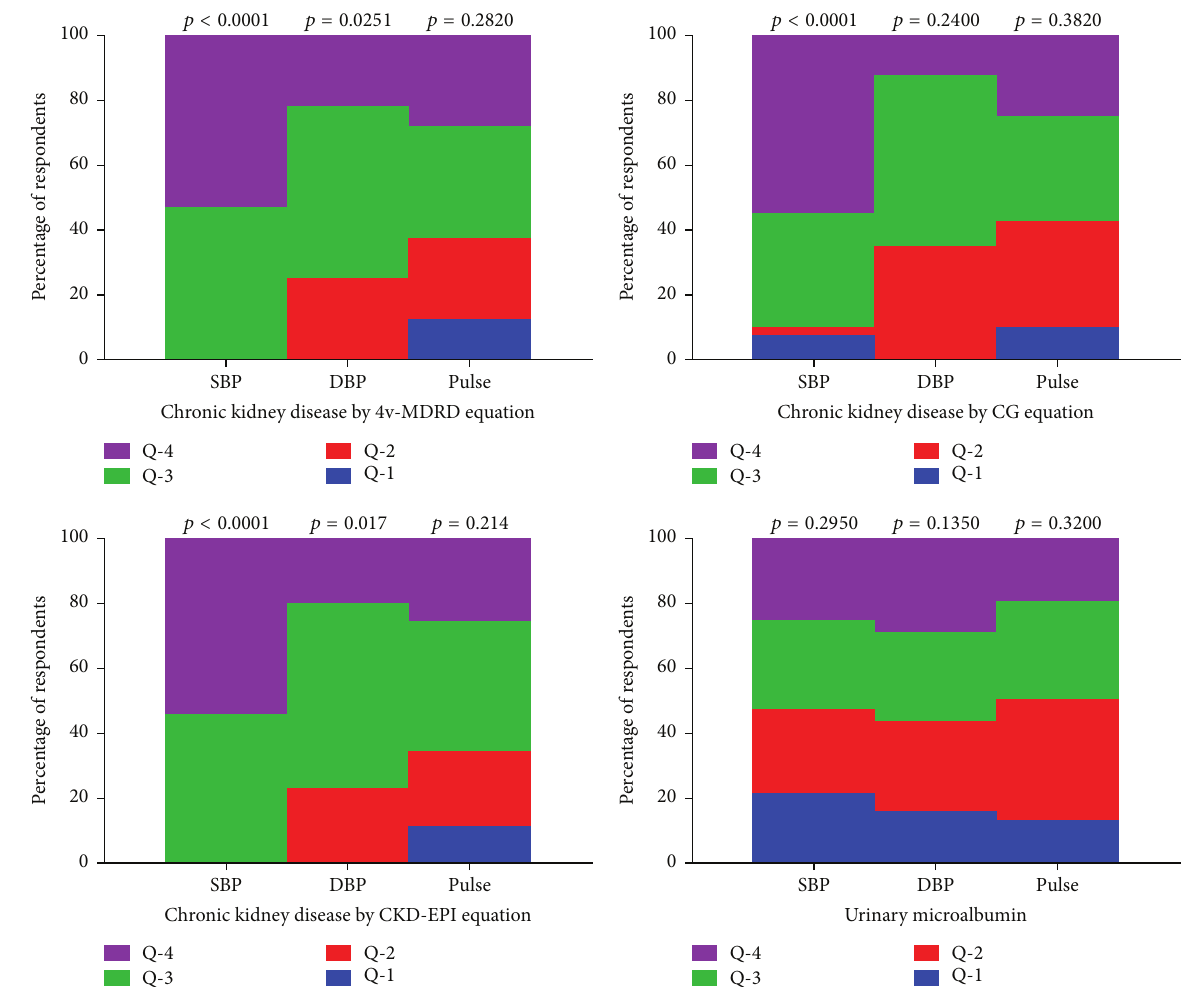
Figure 3: Renal insufficiency quartile cluster distributions with haemodynamic parameters. SBP: systolic blood pressure, DBP: diastolic blood pressure, Q-1: first quartile, Q-2: second quartile, Q-3: third quartile, and Q-4: fourth quartile. 𝑝 value for linear by linear association is significant at 0.05 for two